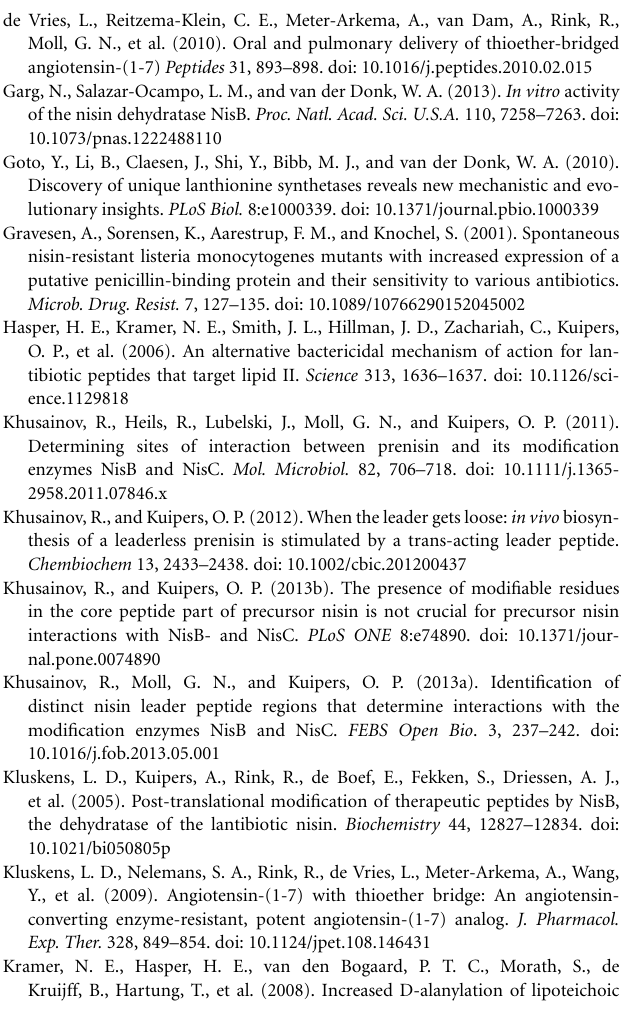
sidechain of His961 also the sidechains of Arg826 and Arg786 are indicated which have been indicated to be important for glutamylation previously (Garg et al., 2013). The vicinity of the glutamylation domain ( A ) seems to allow for some amino acid changes whereas the surrounding of the glutamate elimination domain ( B ) seems to be more strictly determined. Image was created using UCSF chimera version 1.10.1 (Pettersen et al.,